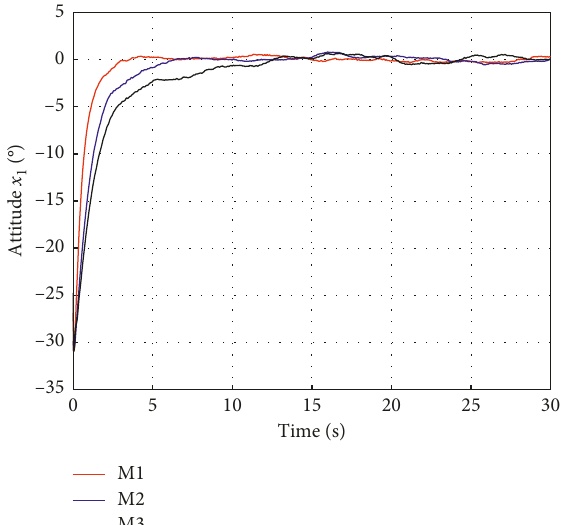
Figure 4: Time response of the attitude x